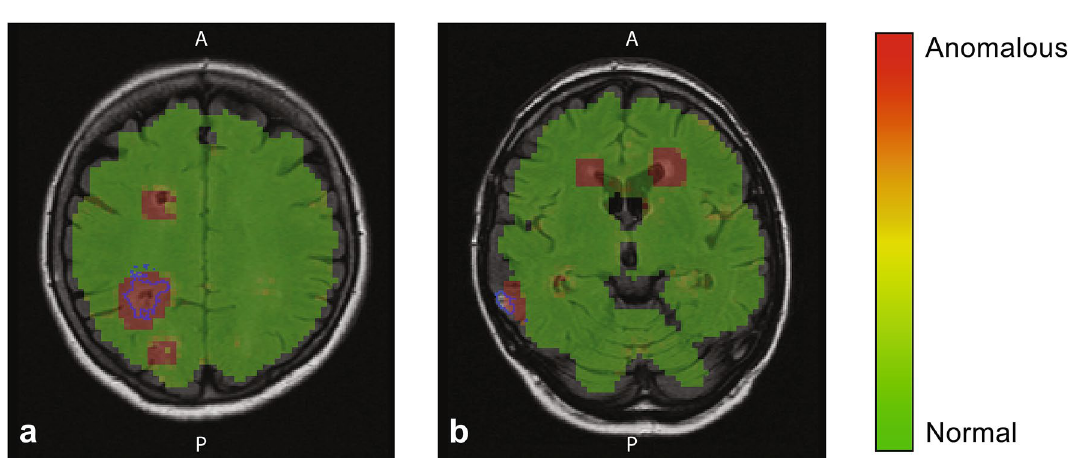
Figure 4. Brain infarct detection performance for various latent vector sizes and percentile values N, used in the anomaly score calculation. ( a ) Free Response Operator Curve for all latent vector sizes and ( b ) detected brain infarct volume to total brain infarct volume ratio (given in color). The used percentile ranged between 10 and 75, where for all lines the first datapoint on the left corresponds to 10th percentile, and the right corresponds to the 75th percentile. The inset in ( a ) shows the used percentiles for a latent vector size of 100. The highest sensitivity for the lowest number of suspected anomalies per image (68% and 6) is given by a latent vector size of 100 and a percentile of 50.